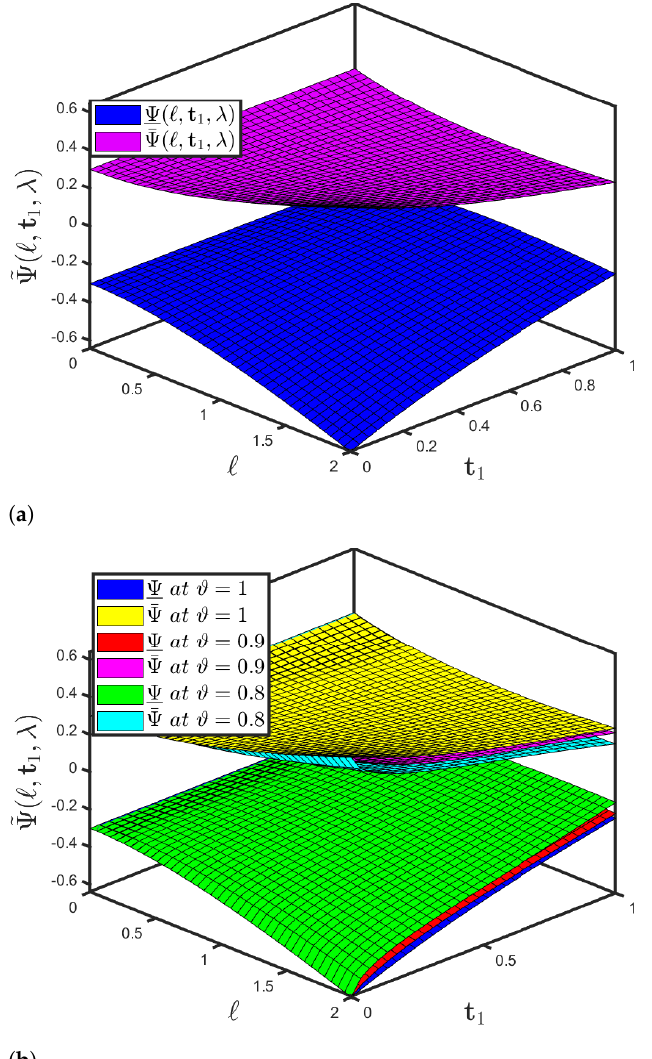
Figure 1. Three-dimensional plot of ˜ Ψ ( (cid:96) , t 1 ; λ ) of Problem (1): ( a ) Ψ ( (cid:96) , t 1 ; λ ) and ¯ Ψ ( (cid:96) , t 1 ; λ ) when ϑ = 1; and ( b ) Ψ ( (cid:96) , t 1 ; λ ) and ¯ Ψ ( (cid:96) , t 1 ; λ ) when the uncertainty parameter λ ∈ [ 0,1 ] has different fractional